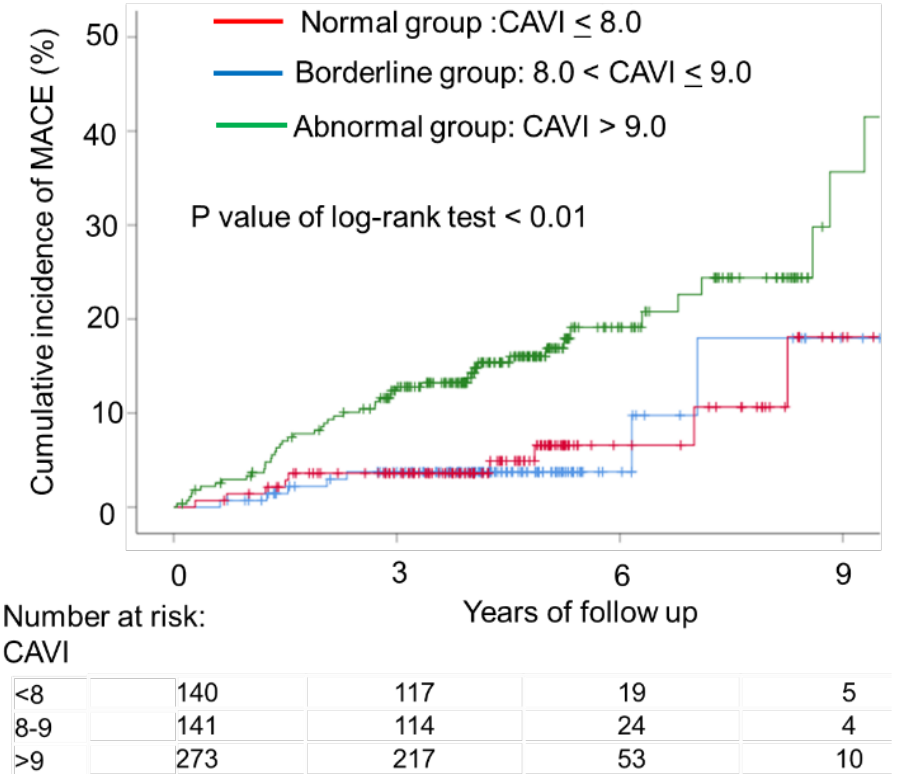
Figure 1. Kaplan – Meier plot of cumulative probability of cardiovascular events by cardio-ankle vas- cular index (CAVI) levels. Time to cardiovascular events, including cardiovascular death, nonfatal stroke, nonfatal myocardial infarction, heart failure requiring hospitalization, and coronary revas- cularization, according to baseline CAVI. The cumulative incidence rates of cardiovascular events according to CAVI levels were significantly higher in the abnormal group (CAVI > 9.0) than in the normal (CAVI < 8) and abnormal groups (8 < CAVI ≤ 9) ( p -value for trend < 0.01).